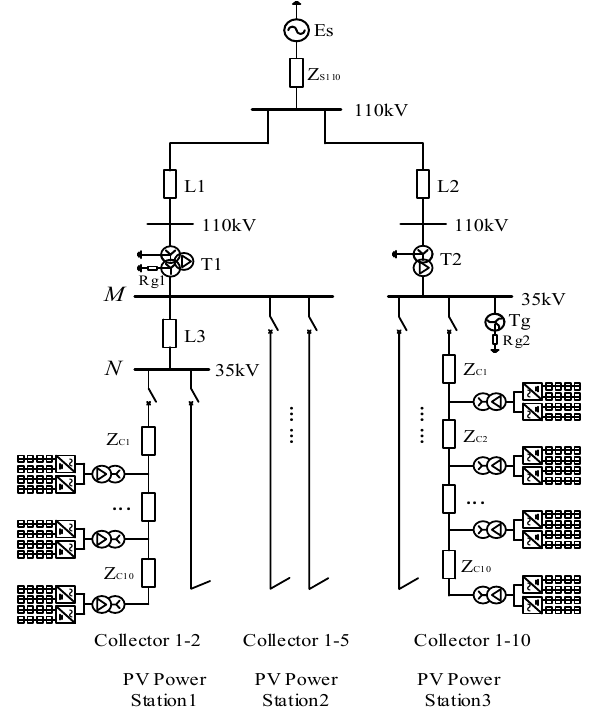
Figure 6. Grid-connected system of multiple PV power stations.